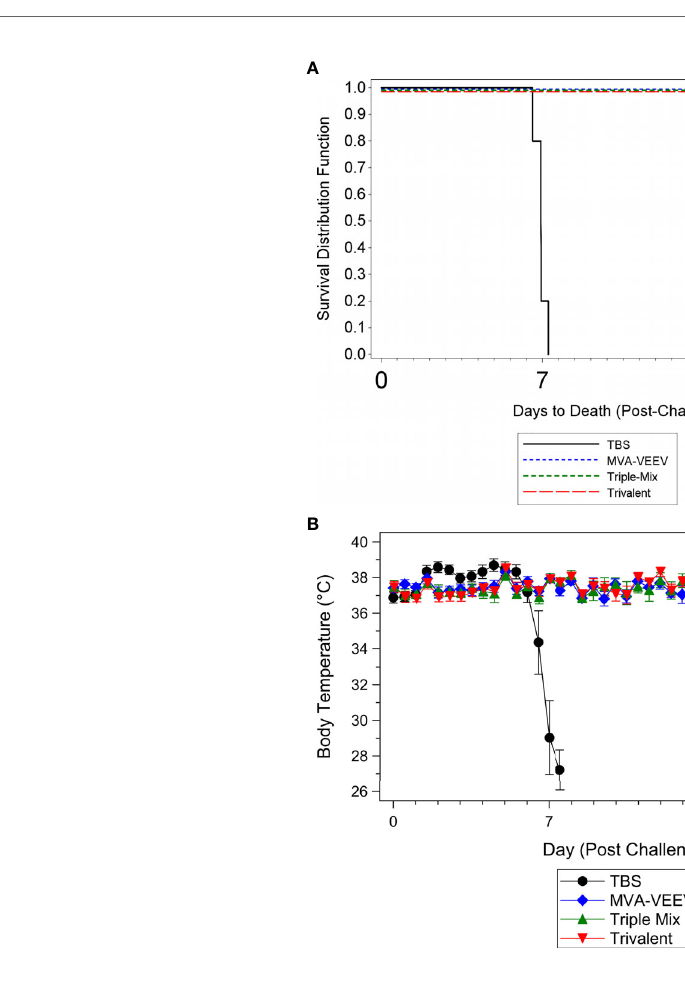
FIGURE 2 | Survival and Body Temperature Changes after VEEV TrD Aerosol Challenge of Immunized Mice. Mice were immunized (IM) twice (Day 0 and 28) with the respective vaccine or TBS and then exposed to an aerosolized dose of VEEV TrD on Day 42. Kaplan-Meier plots of survival results (A) and changes in body temperature during the post-challenge period (B) . There was a signi fi cant difference in survival between the TBS group and all three vaccination groups (p < 0.01). In addition, there was a signi fi cant (p < 0.05) temperature decrease for the TBS control group (B) prior to succumbing to infection or meeting euthanasia criteria and a signi fi cant difference between the TBS control group and the vaccinated groups on Days 44 – 49 (p < 0.05). Ten animals per group were evaluated for survival and body temperature